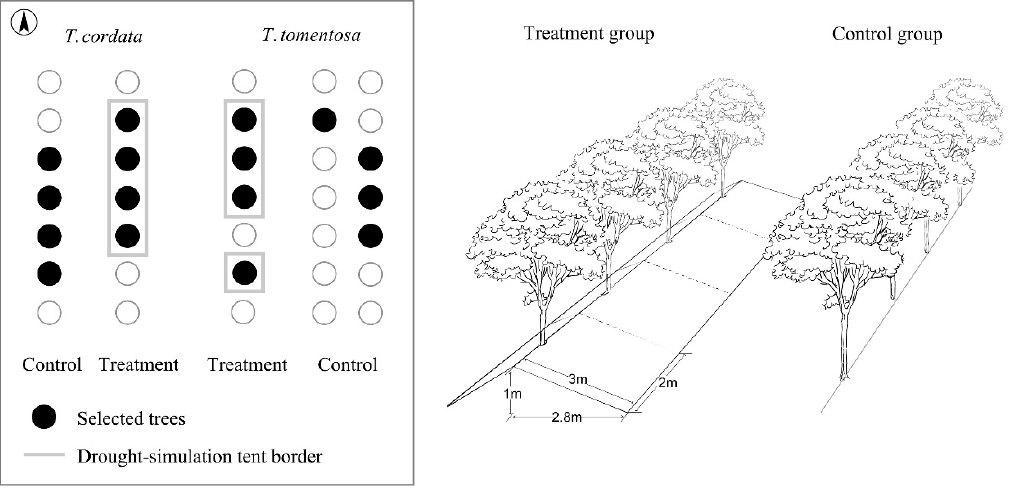
Figure 1. Schematic structure of the drought experiment and selected trees of Tilia cordata and Tilia tomentosa. The rooting zones of trees covered by the rainfall exclusion constructions were the drought treatment group, whereas trees exposed to ambient weather conditions for the control group.